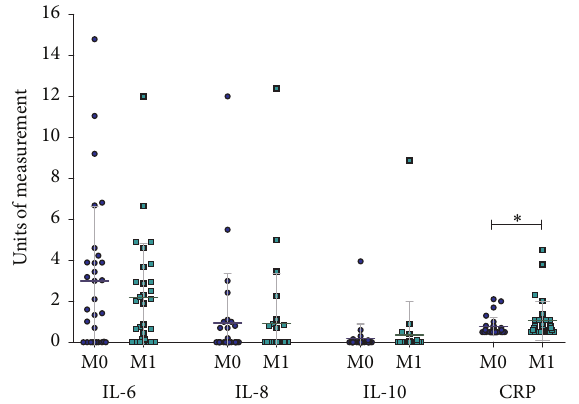
Figure 3: Changes in plasma levels of cytokines and CRP of 30 PLWHA, before and after cART initiation. PLWHA: people living with HIV/AIDS; cART: combined antiretroviral therapy; IL: interleukin; CRP: C-reactive protein; M0: before cART initiation; M1: after cART initiation. Statistical tests: gamma distribution. ∗ 𝑝 < 0.01 . Units of measurement: “mg/dL” to CRP and “pg/mL” to